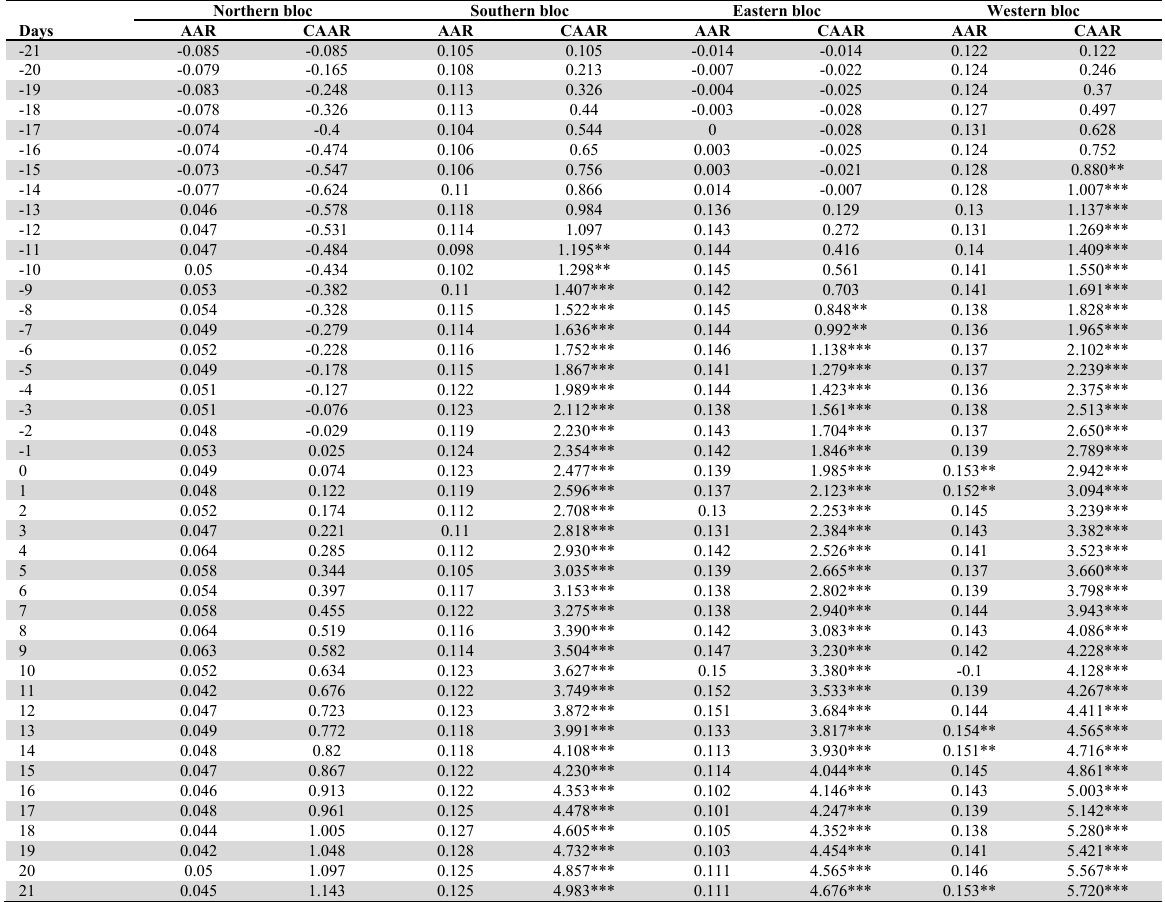
AARs and CAARs 21 days before and 21 days after the event of COVID-19 vaccination Northern bloc Southern bloc Eastern bloc Western bloc